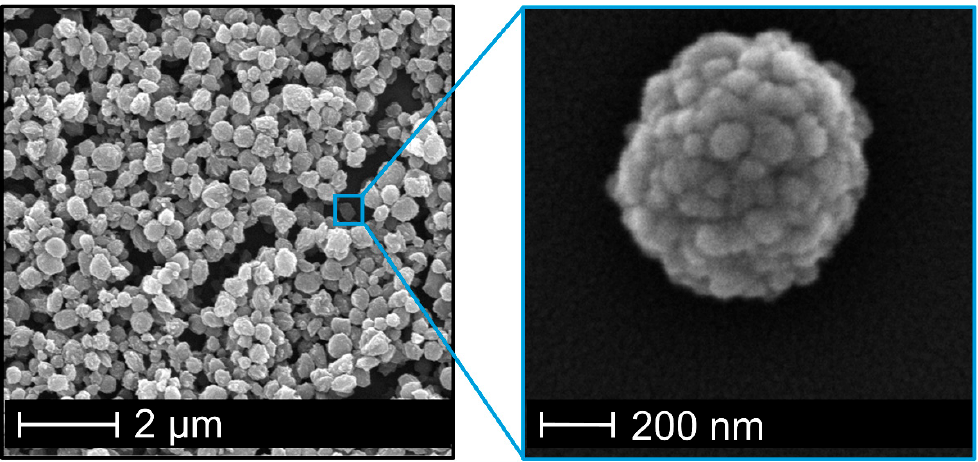
Figure 2. SEM image of cellulose acetate nanoparticles with strongly structured surface resulting of agglomeration of smaller substructures.